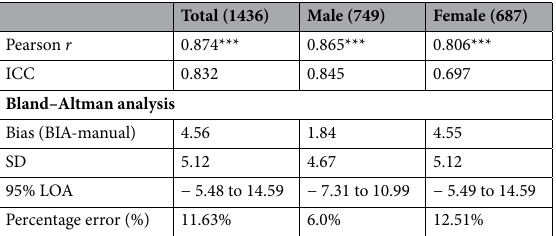
Table 2. Correlation coefficient ( r ), ICC, and Bland–Altman analysis between anthropometry and BIA for